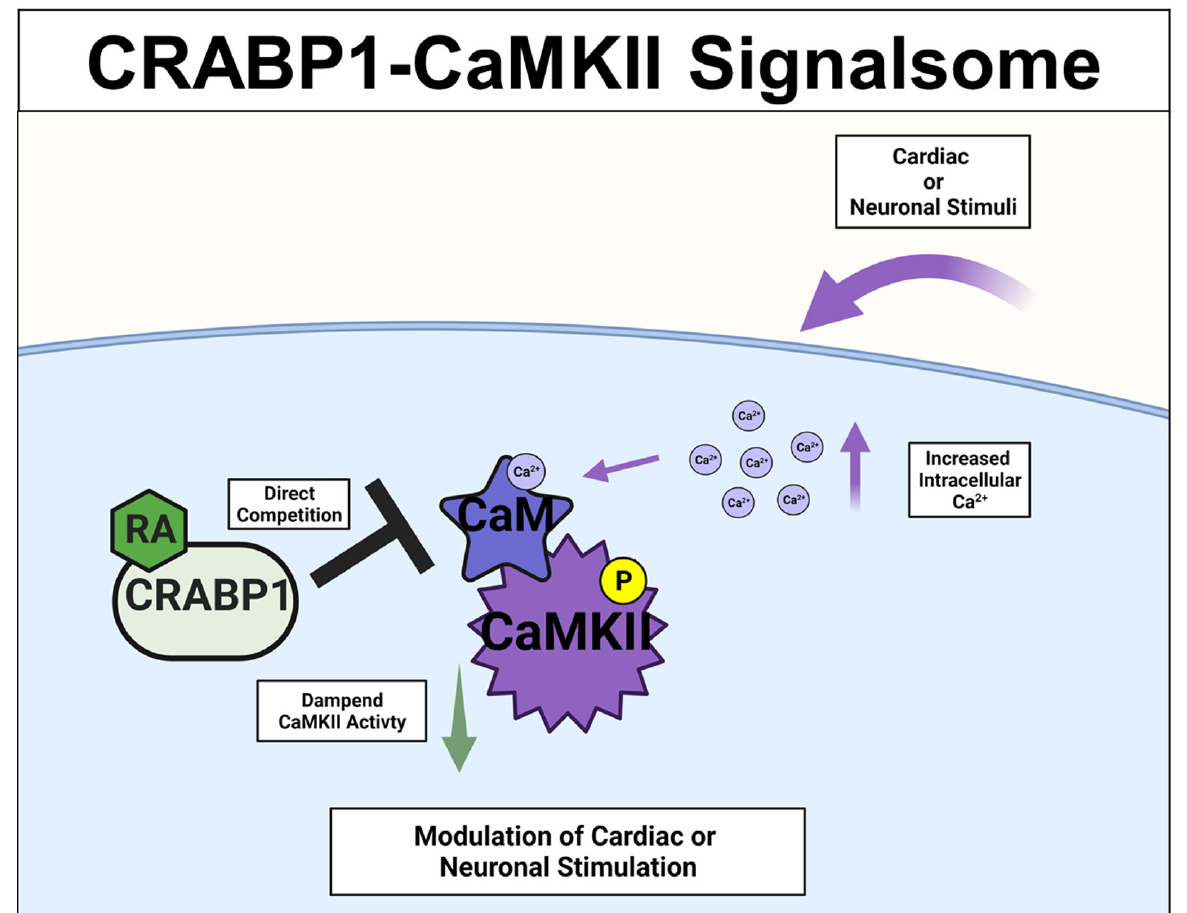
Figure 3. CRABP1-CaMKII signalsome. Upon cardiac or neuronal stimulation and subsequent in- tracellular Ca 2+ increase to activate CaMKII, CRABP1 directly competes with calmodulin (CaM) to dampen CaMKII enzyme activity to ultimately modulate cardiac and/or neuronal stimulation. CRABP1: Cellular Retinoic Acid Binding Protein 1, RA: retinoic acid, CaMKII: calcium-calmodulin- associated dependent kinase 2.